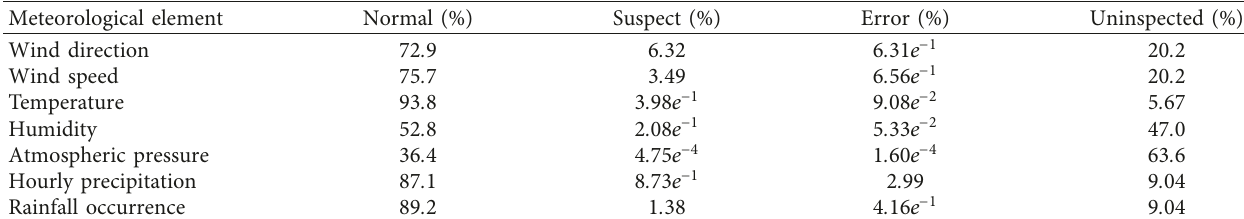
Table 13: Results of the proposed spatial quality control